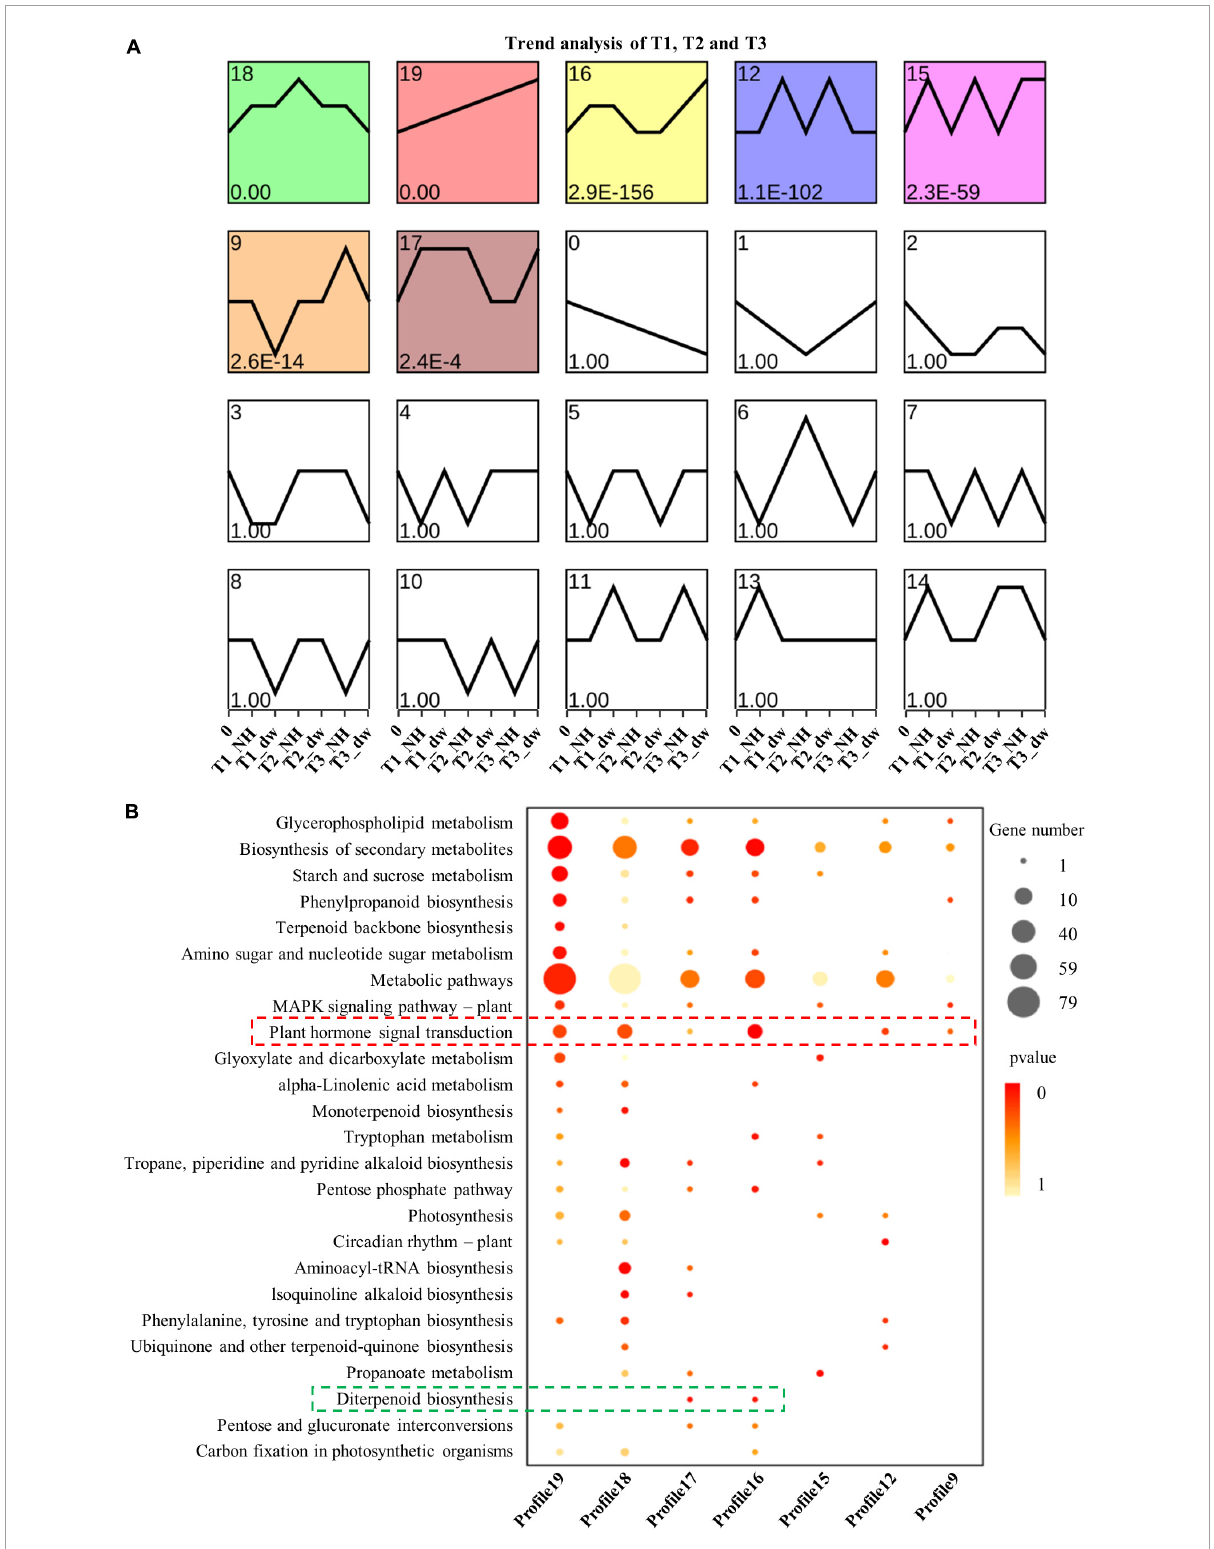
FIGURE3 Trend analysis and KEGG enrichment analysis of significant cluster profile. (A) Trend cluster analysis of all DEGs at T1, T2, and T3; colored boxes represent profiles with significant differences. (B) KEGG enrichment and scatter plots of all genes in trend